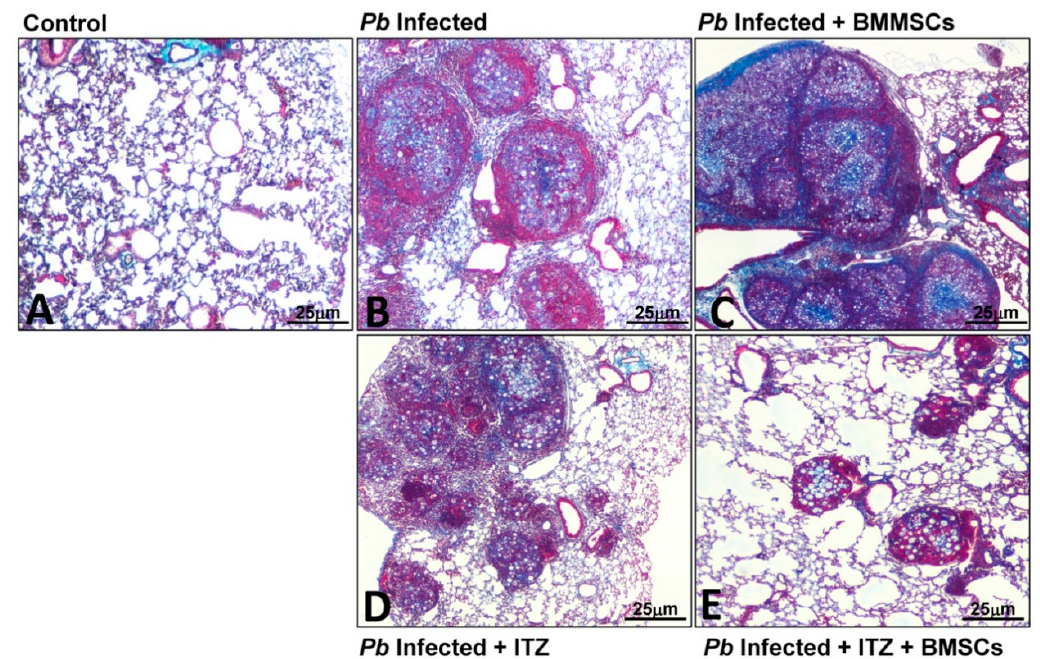
Figure 2. Combined therapy using itraconazole and bone marrow mesenchymal stem cells (BMMSCs) reduces pulmonary inflammation and fibrosis in the lungs of mice infected with P. brasiliensis .